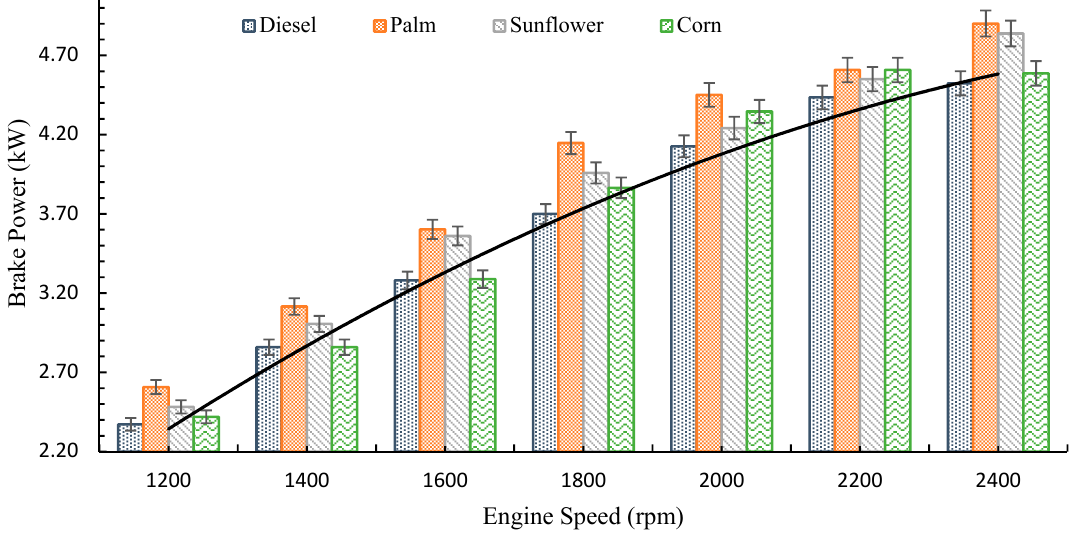
Figure 5. Variation of brake power vs. engine speed for different biodiesel blends.